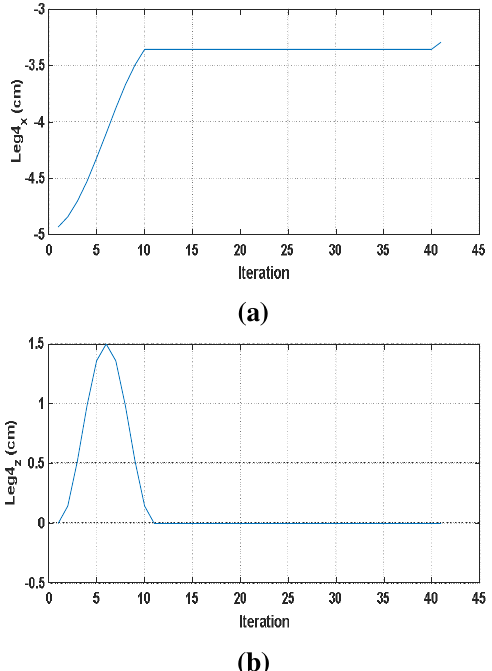
Fig. 16. When Leg 4 is swinging. (a) Leg 4 moved one step along X-axis. (b) Leg 4 moved one step along